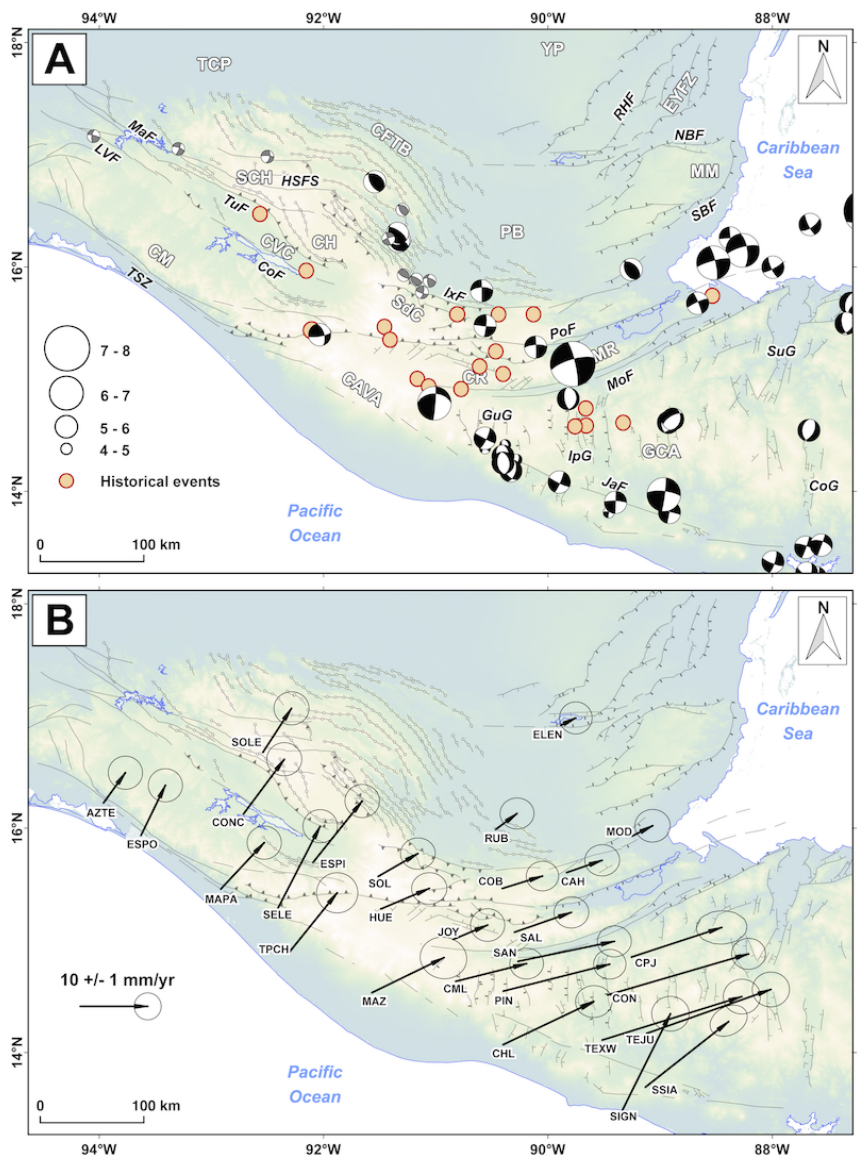
Figure 3. Superficial (depth < 40km) seismicity in northern Central America (a) and GPS velocities with respect to the fixed North American Plate (b) . Focal mechanisms from Guzmán-Speziale et al. (1989), Guzmán-Speziale (2010) (in greys) and Global CMT Catalog (in black, http://www.globalcmt.org). Historical earthquakes (red circles) from White (1984), Singh et al. (1984) and Guzmán-Speziale (2010). GPS velocities are from Franco et al. (2012). See Fig. 2 for